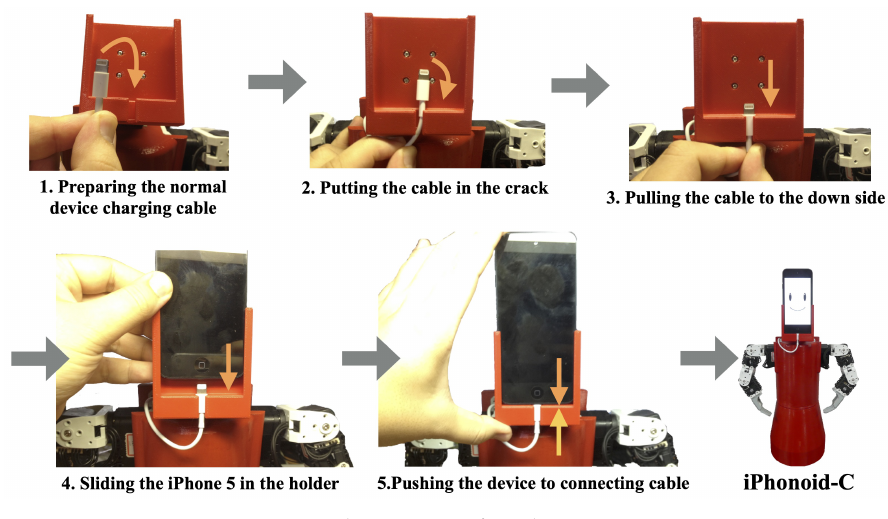
Figure 3. Plugin system for robot partners.